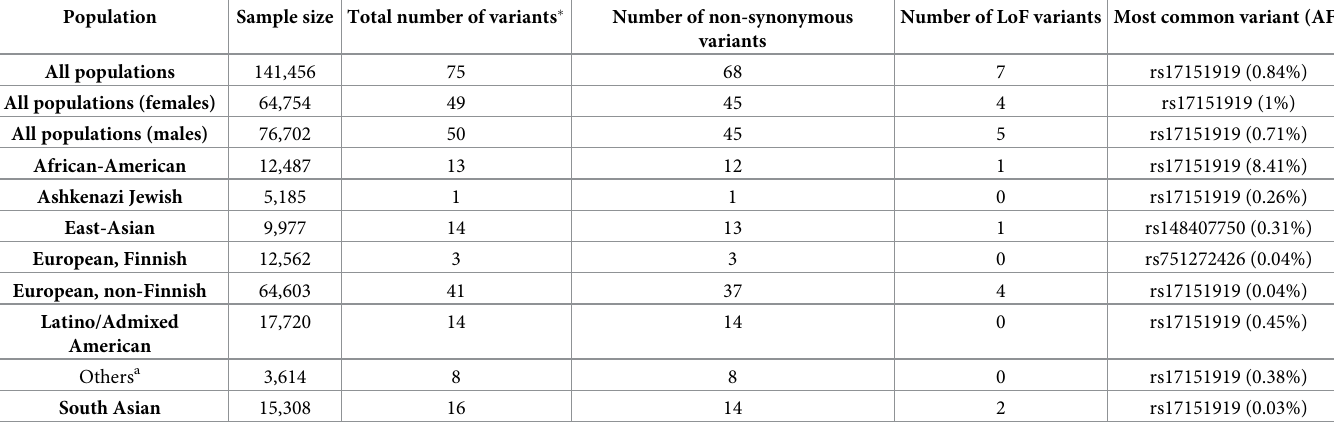
Table 1. Summary of non-synonymous and LoF variants in the LEP gene deposited in gnomAD.